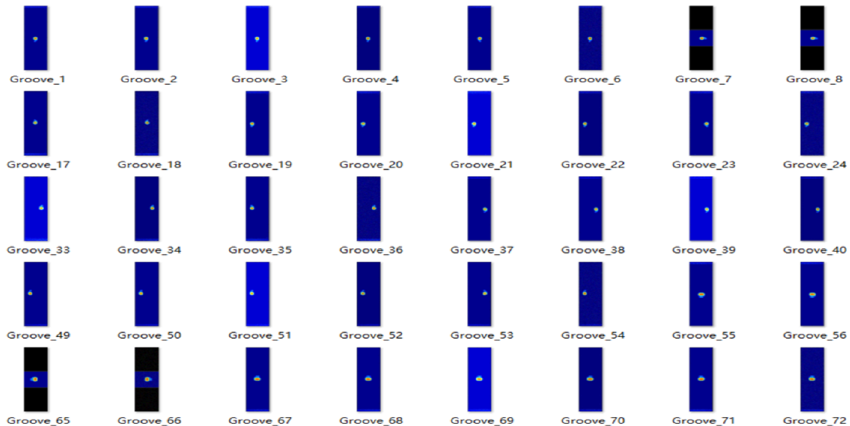
Figure 4. SDH augmented dataset.